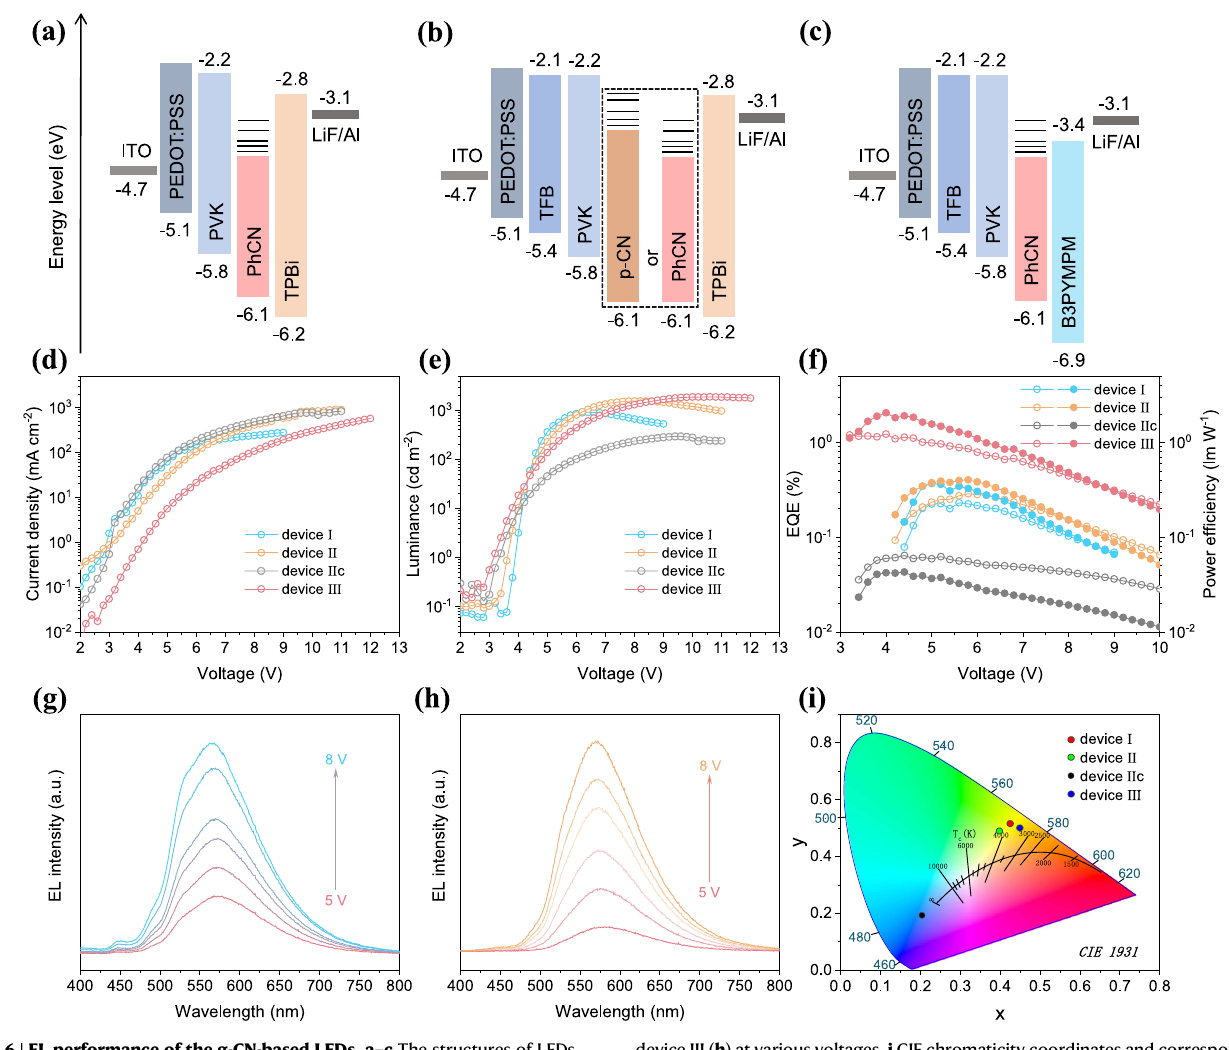
deviceIII( h )atvariousvoltages. i CIEchromaticitycoordinatesand corresponding colortemperaturesforLEDdevices.Thepink,green,black,andbluedotsrepresent devices I, II, IIc, and III,